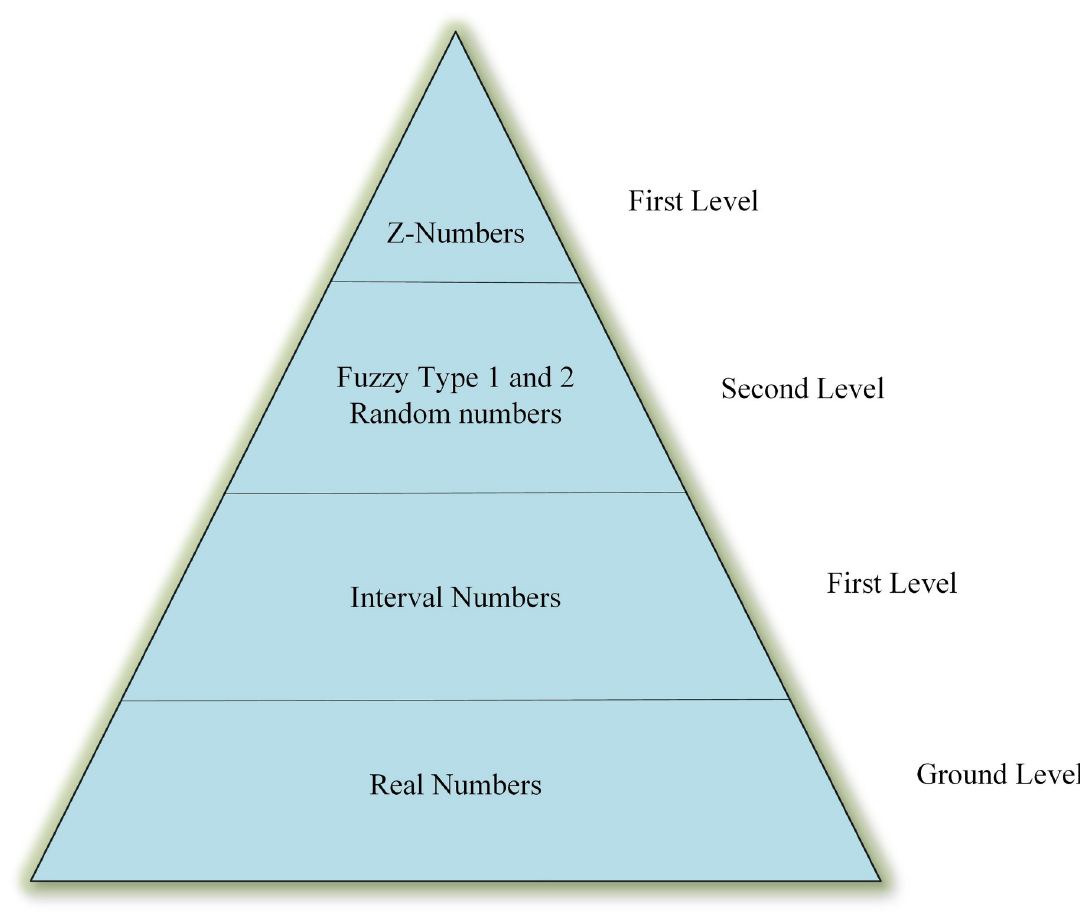
Fig 1. Hierarchical structure of